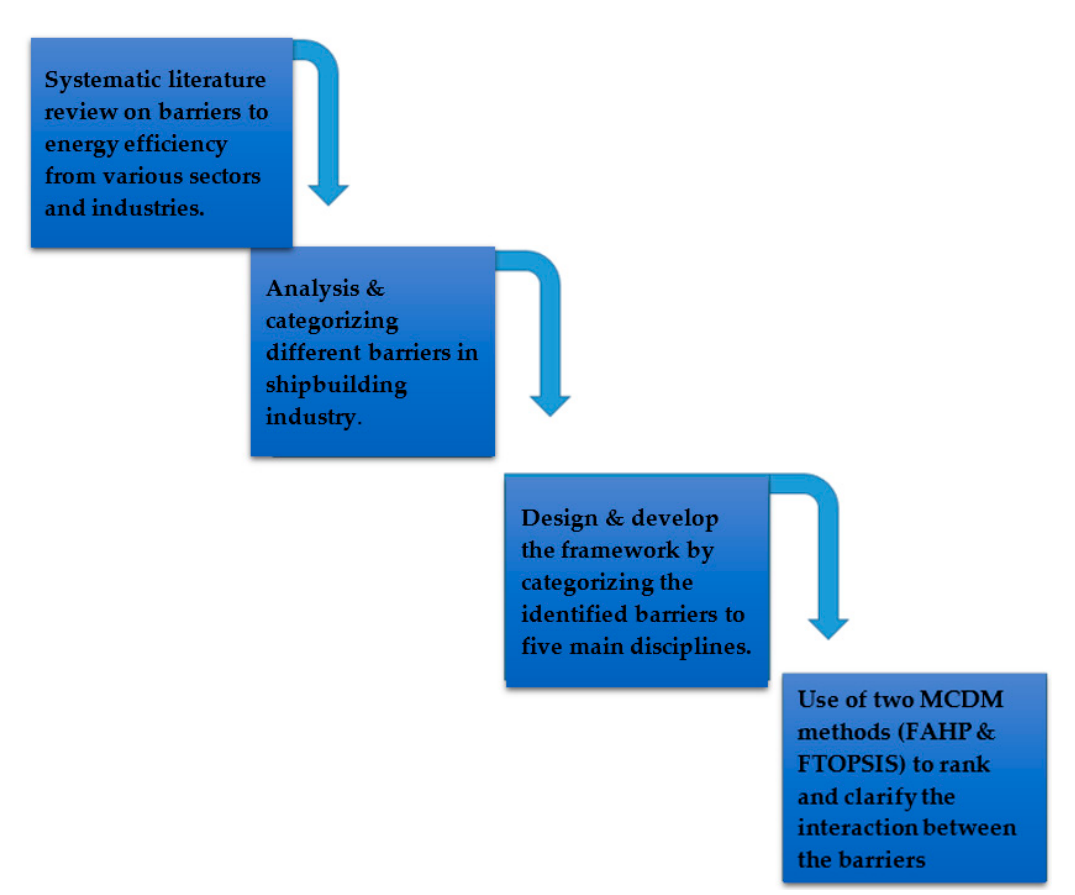
Figure 1. Research design and sequences of the study.